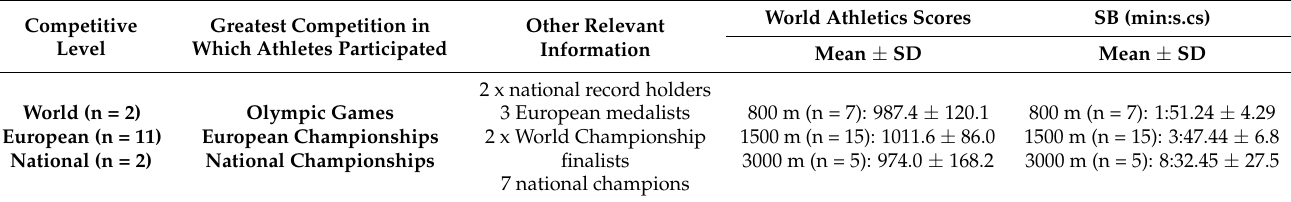
Table 1. Performance characteristics of